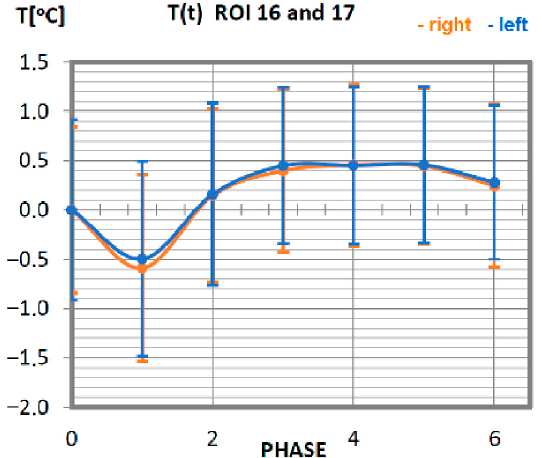
Figure 10. Temperature time (0 to 6 phase of training according to methods) changes of the quadriceps muscle obtained before and after training using a rowing ergometer for the studied group of athletes.